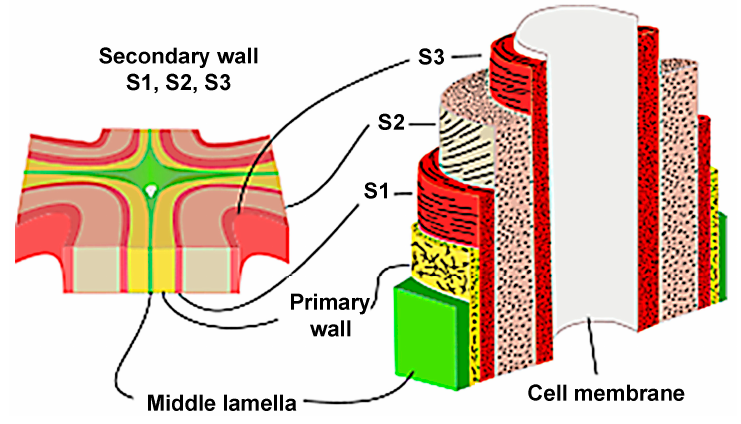
Figure 2. Layered construction of wood cell wall.